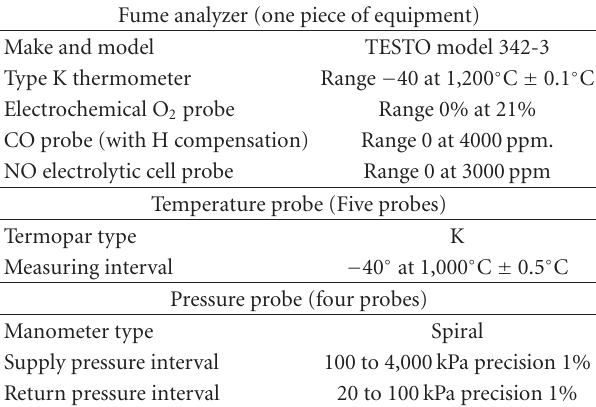
Table 7: Measuring equipment used in the tests, with the measuring range.